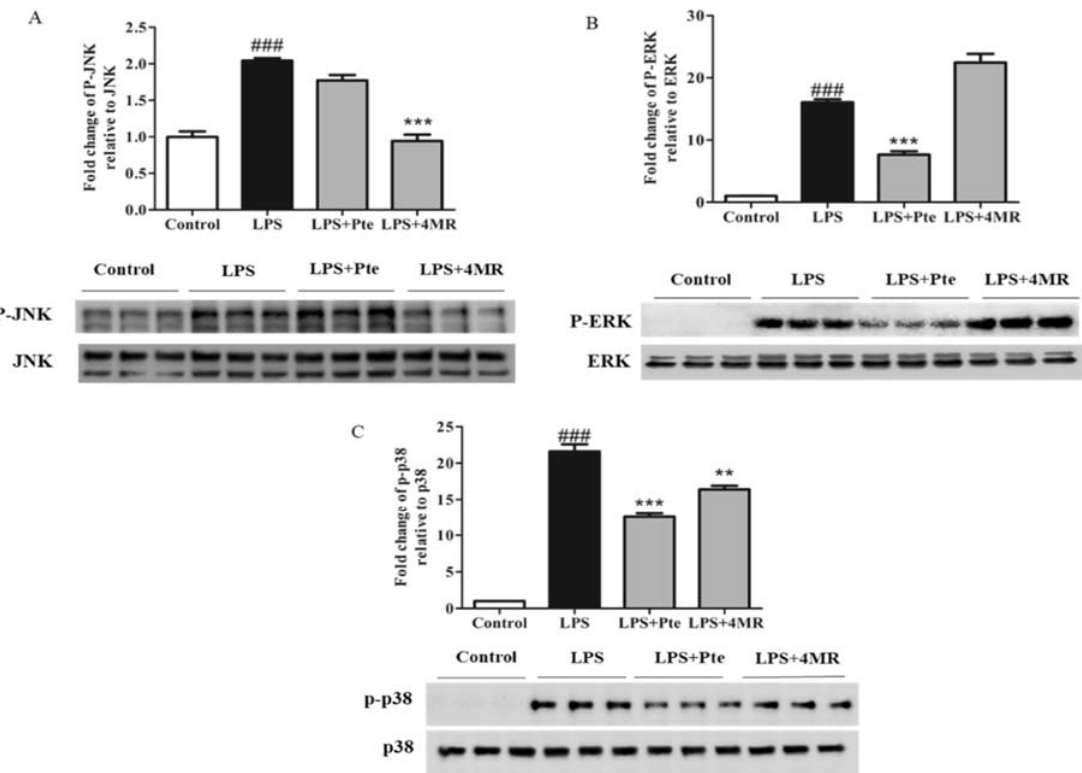
Figure 7. Effect of Pte and 4MR on LPS ‐ induced ( A ) p ‐ JNK, ( B ) p ‐ ERK, and ( C ) p ‐ p38 protein expression in RAW264.7 cells. The protein expression levels were measured by Western blot. Cells were cotreated with both LPS (0.1 μ g/mL) and Pte (5 μ M) or 4MR (5 μ M) for 30 min. The data were representatives of three independent experiments and were presented as the mean ± SEM. ### p < 0.001 compared to control; ** p < 0.01, *** p < 0.001 compared to LPS alone.